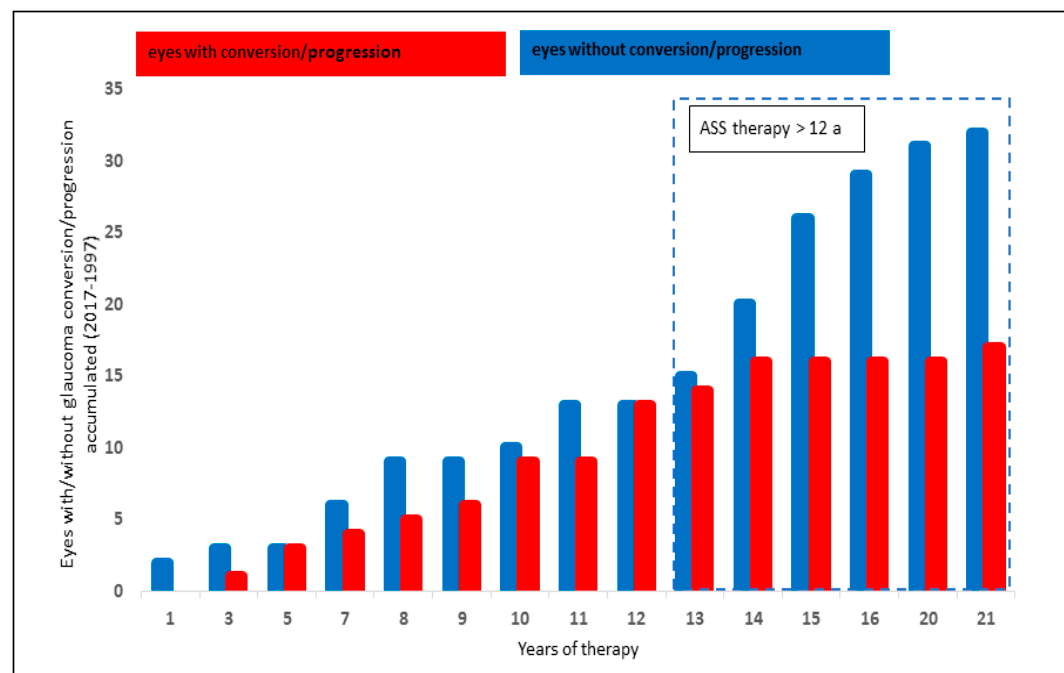
Figure 3. Effect of ASS therapy on glaucoma progression and glaucoma conversion rate.